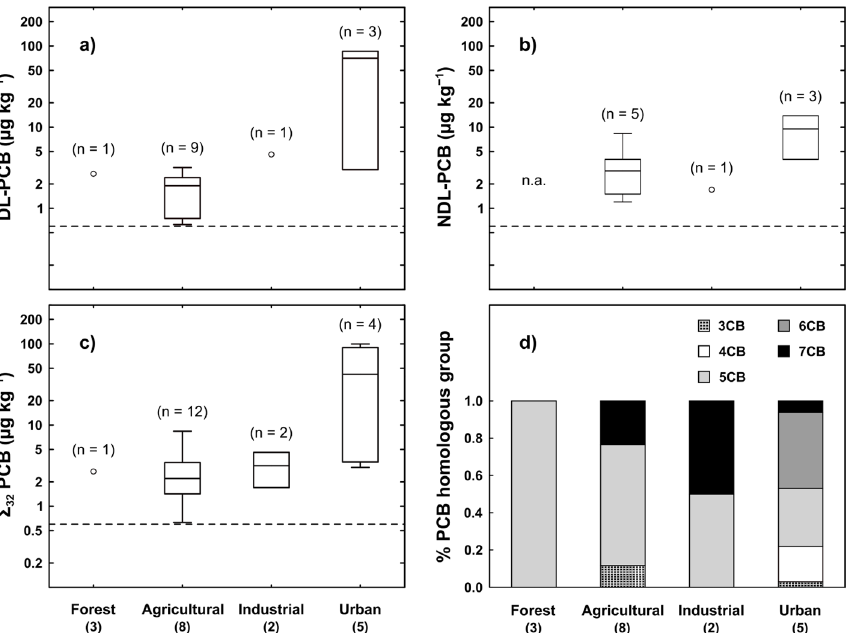
Figure 3. Statistical comparison (Kruskal–Wallis Test) among the concentration sums of the 12 dioxin ‐ like ( Σ 12 DL ‐ PCB) ( a ), 20 non ‐ dioxin ‐ like ( Σ 20 NDL ‐ PCB) ( b ), and all 32 PCB congeners ( Σ 32 PCB) ( c ) measured in Robinia pseudoacacia leaf samples collected in forest, agricultural, industrial, and urban strata of the study area of Figure 1; the analysis was based on the 19 samples with PCB content > LOD (black dotted line). The average of the percentage of PCB homologous groups calculated for leaf samples collected in the strata is given in ( d ). The numbers in brackets below the labels of the x ‐ axis corresponds to the samples with PCB content < LOD.